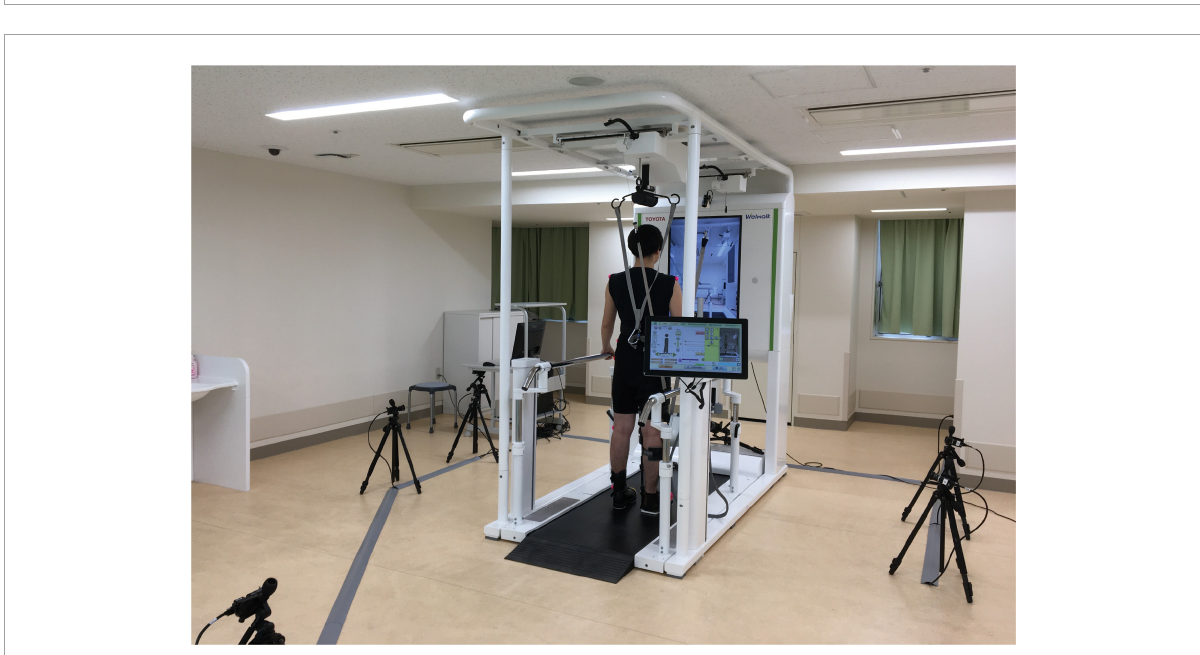
FIGURE2 Measurement environment. Five CCD cameras were placed around the Welwalk WW-2000 to record gait patterns during the tasks using a marker-based motion capture system and the gait analysis system in Welwalk WW-2000.